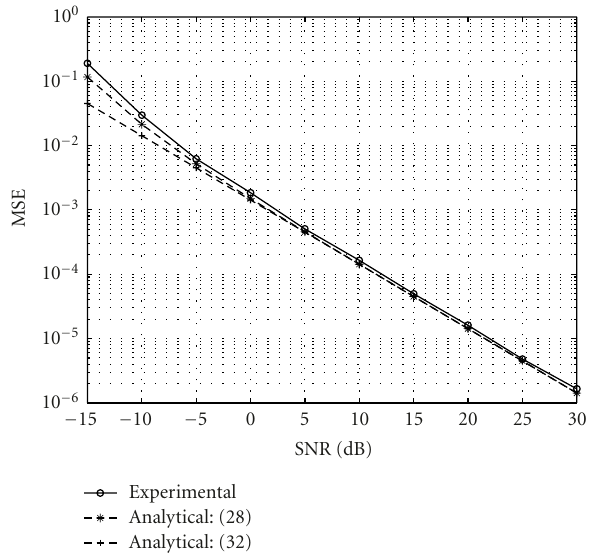
Figure 1: The MSE of the estimated channel versus SNR. The WP algorithm.